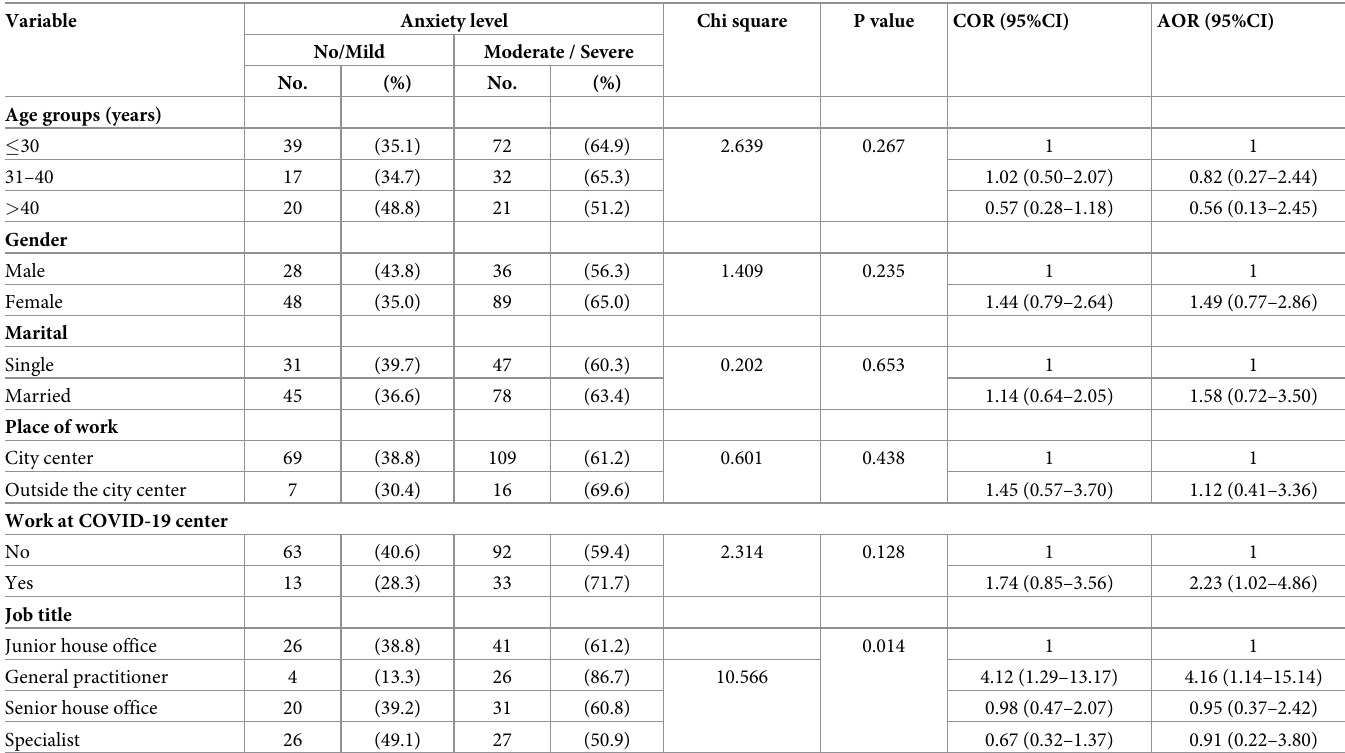
Table 7. Factors associated with anxiety among